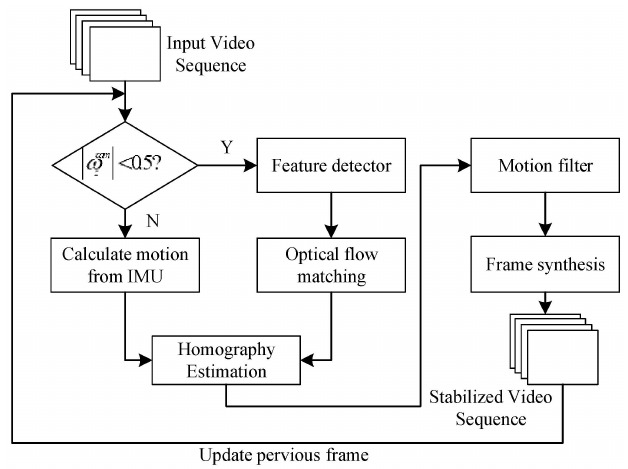
Figure 1. Flowchart of our proposed